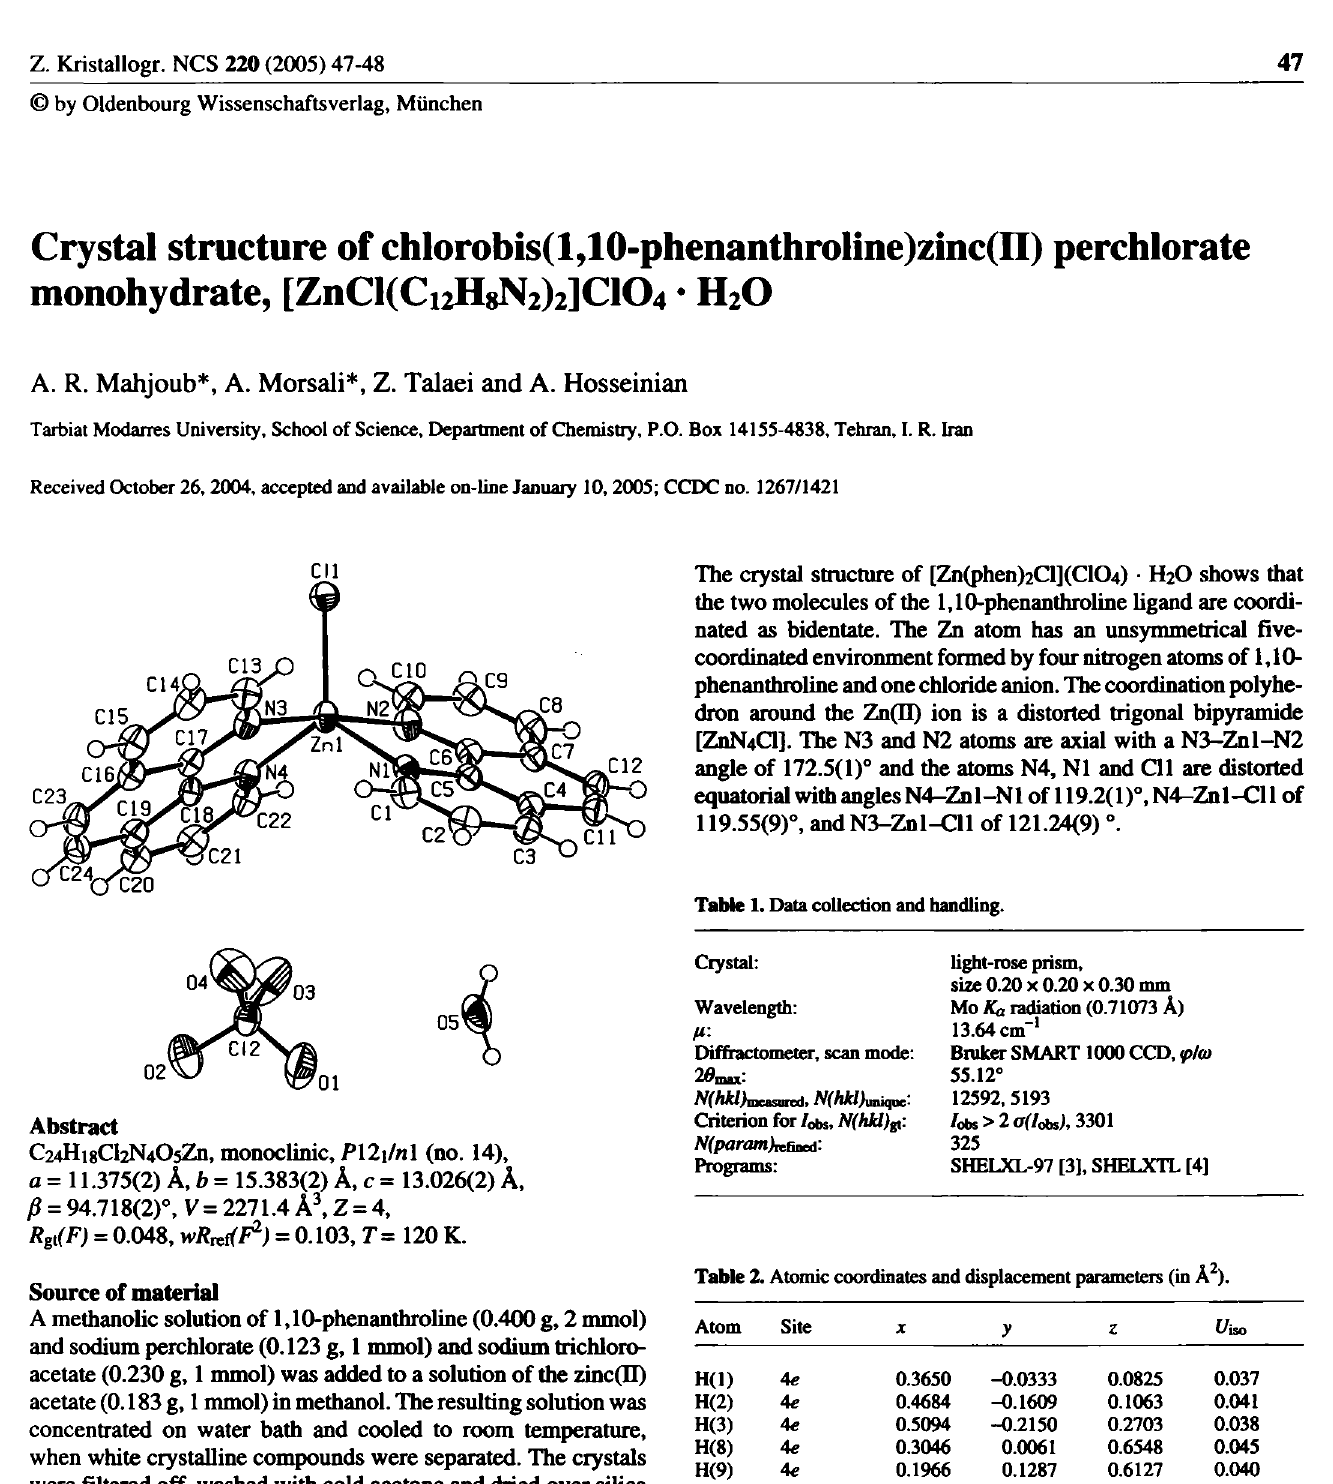
Table 2. Atomic coordinates and displacement parameters (in A 2